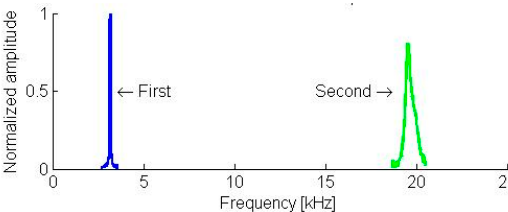
Figure 43. The free vibration resonance spectrum of a 5 mm long piezo-resistive cantilever microprobe.